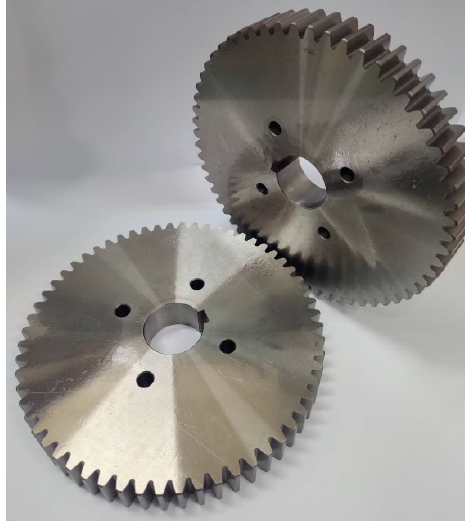
Figure 8. Test gear pair.